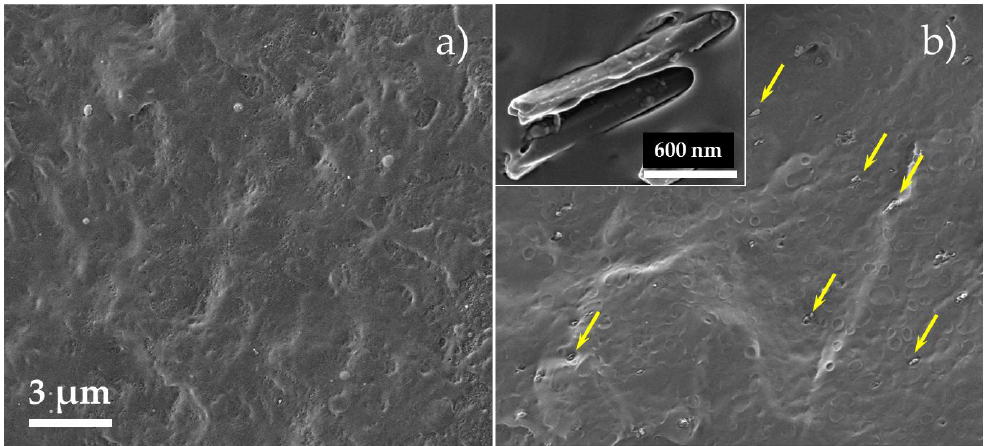
Figure 1. High-resolution scanning electron microscope (HR-SEM) images of cryo-fractured cross-sections of ( a ) neat PP and ( b ) PP/(HNTs-carvacrol) films. Several HNTs are marked with arrows for clarity. The HNTs are finely dispersed within the PP matrix. The inset shows a high-magnification micrograph, depicting HNTs protruding from the PP matrix. The HNTs exhibit a characteristic morphology of cylindrical tubes, with an external diameter of up to 100 nm. Table 2. Carvacrol content in different films measured by thermal gravimetric analysis (TGA). Pre-Processing Content of Polymer Films